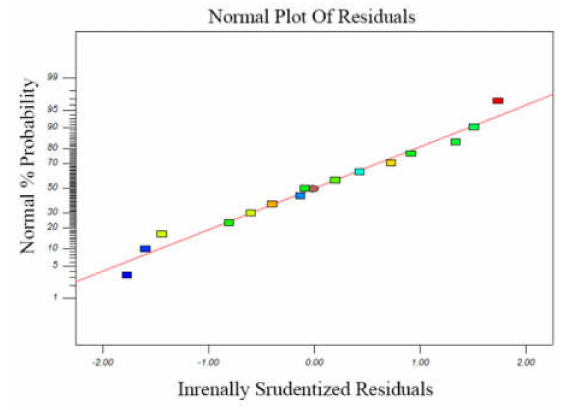
Figure 7. The normal plot of residuals of the maximum failure